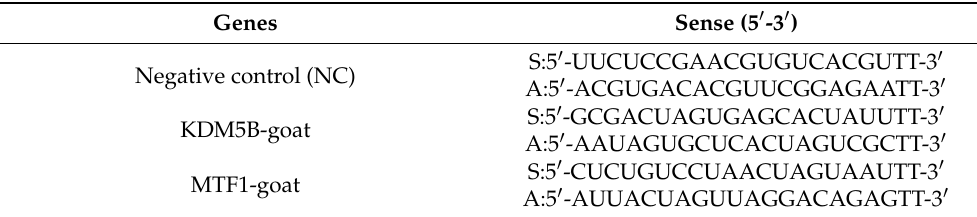
Table 1. Details of siRNA sequences used for cell transfection.